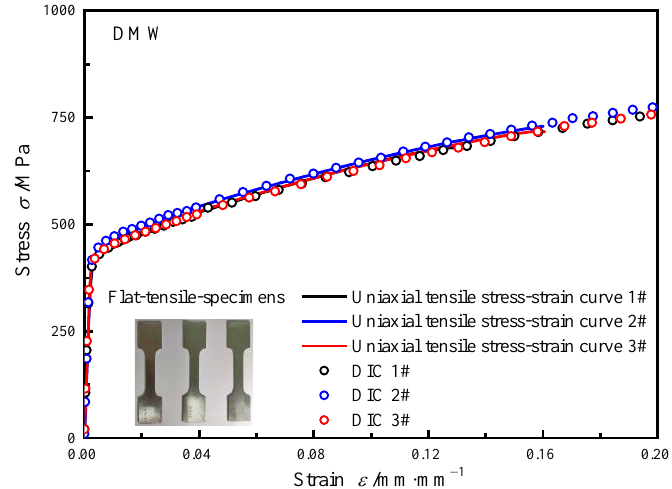
Figure 17. The results of tension stress-strain curves for an SF-DMW joint.